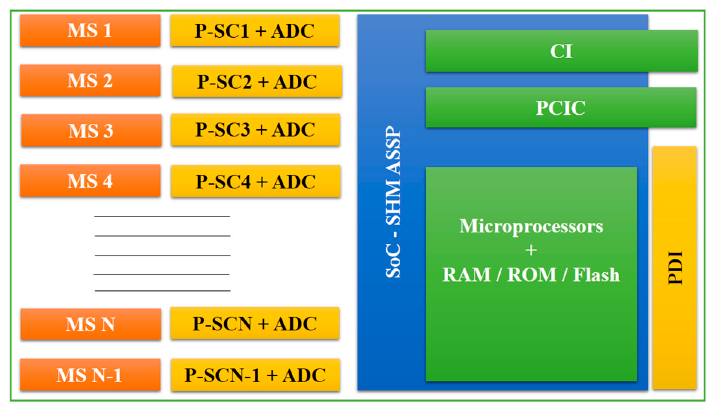
Figure 5. SHM-ASSP ZRC Node Block Figure 5. SHM ‐ ASSP ZRC Node Block Diagram.